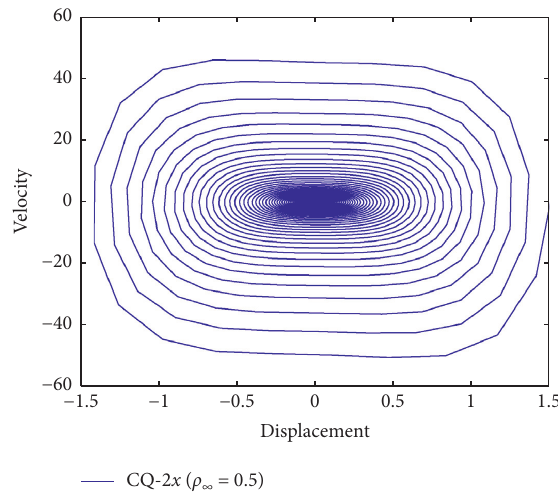
Figure 16: Phase portrait of the hardening spring calculated using � 0 . 5 ) when Δ t � T CQ-2 x ( ρ ∞